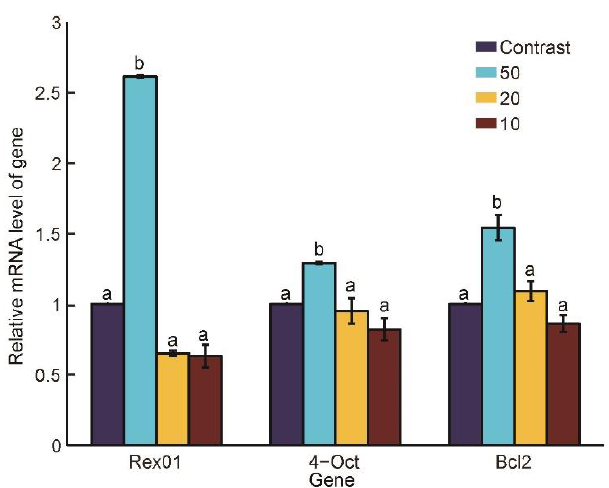
Figure 9. Gene expressions of the embryos at 72 h after oocytes been fused/activated. The Rex01, Oct-4, and Bcl-2 gene expressions at the penetration speed of 50 µ m/s were all significantly higher than those of the control, 20 µ m/s, and 10 µ m/s ( p < 0.05). The a and b in the figure mean the data in b group is significantly different from that of a.